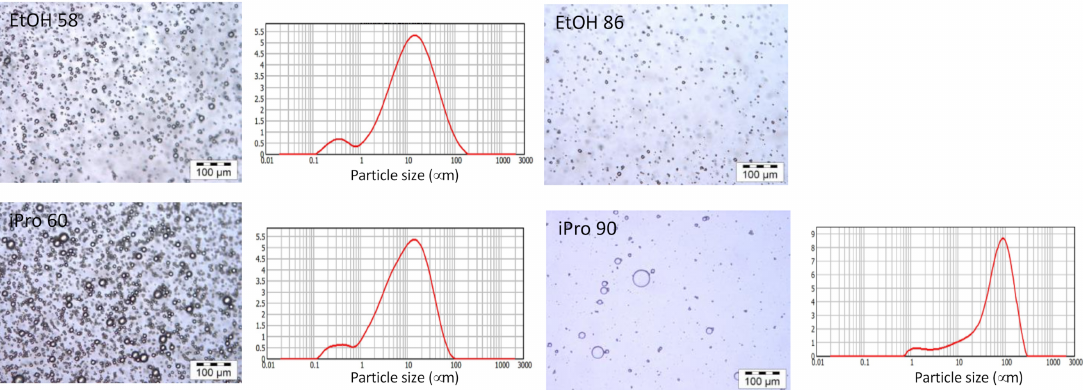
Figure 8. Characterization of washed F1 dispersions. Image of iPro 90 obtained after dilution of the aliquot; vertical axis for PSD is in volume